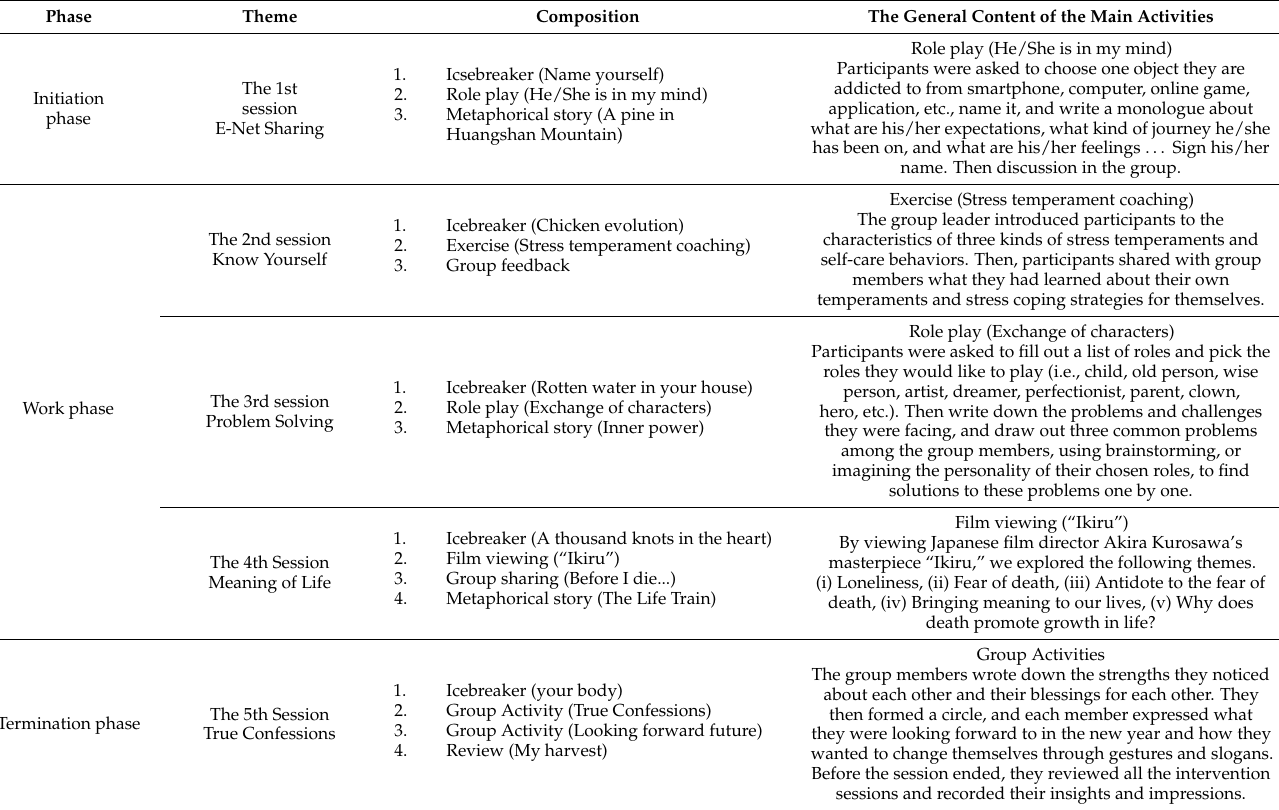
Table 1. Intervention Program